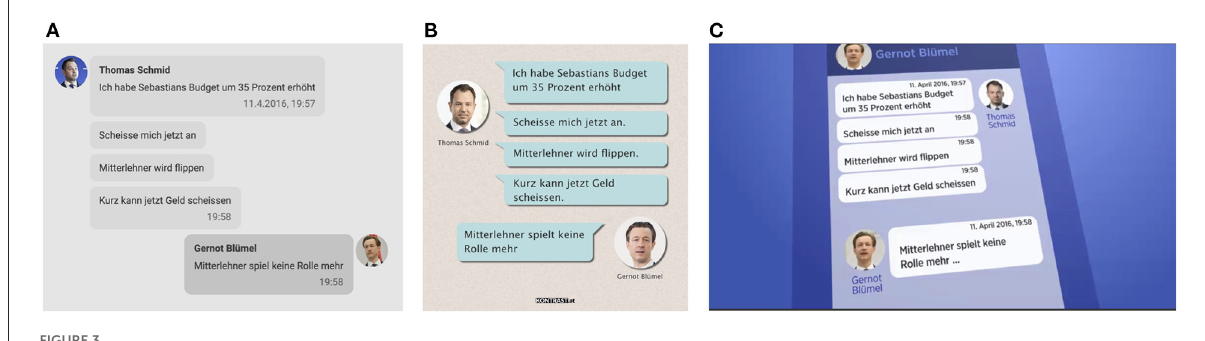
FIGURE3 Three examples of cross-media recontextualization through visual restaging of chat discourse. (A) derstandard.at, (B) kontrast.at, and (C) Zeit im